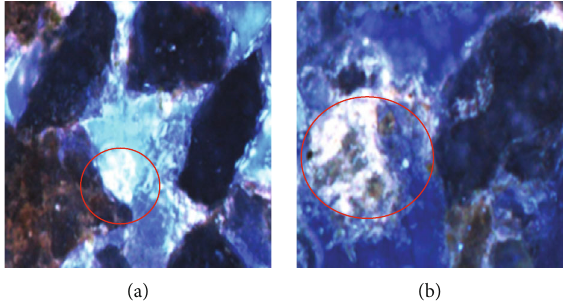
Figure 11: Free-state residual oil. (a) Cluster. (b) Intergranular adsorption.